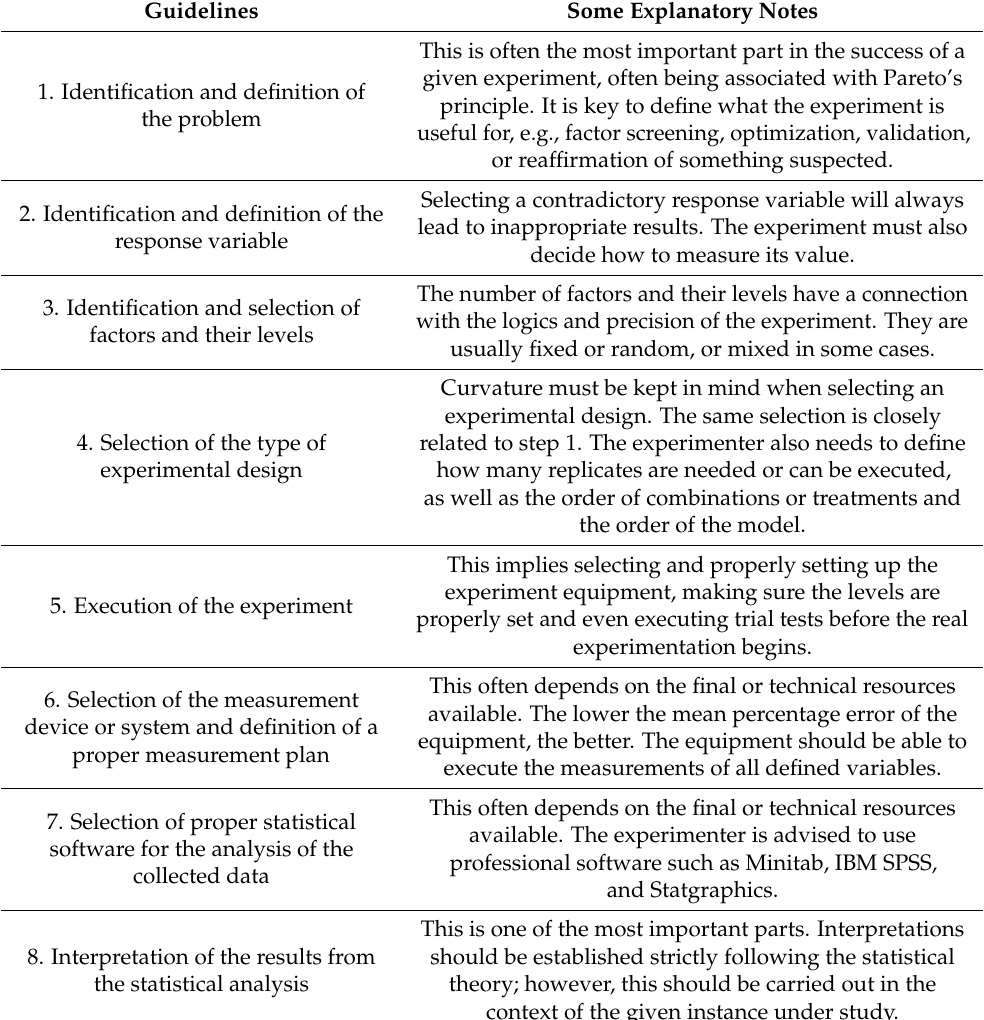
Table 1. General guidelines for designing an